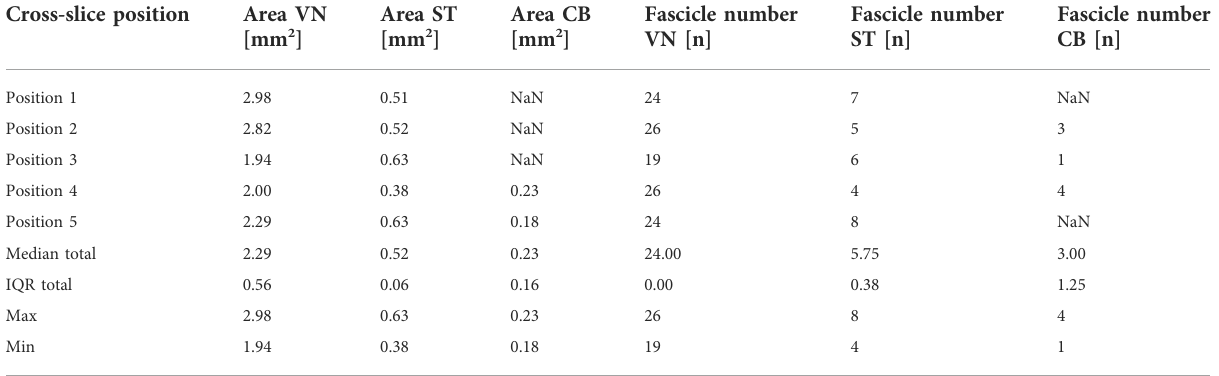
TABLE 2 Measurements of the nerve areas (Area) and fascicle numbers (Fascicle number) at multiple locations along the cervical level down to just caudalto the cardiac branching point across the cohort. Lacking measurements at positions where the corcorresponding nerve was not present or measurable were designated “ NaN ” ( “ not a number ” ). Numbers are represented as median and interquartile range (IQR). Area measurements are givenin[mm 2 ],fasciclenumbersintotalnumbers[n].Theminimum(Min)andmaximum(Max)valuesofthemeasurementsweredeterminedforeach nerve.VN, vaus nerve; ST, sympathetic trunk; CB, cardiac